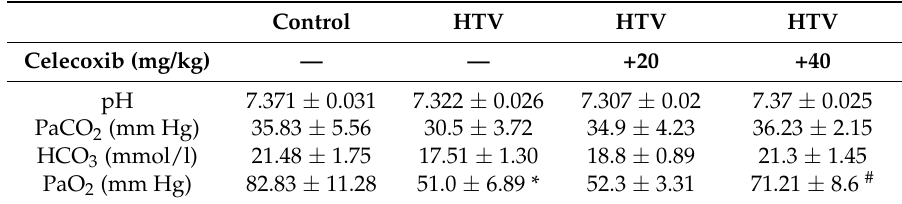
Table 1. Analysis of cardiac blood